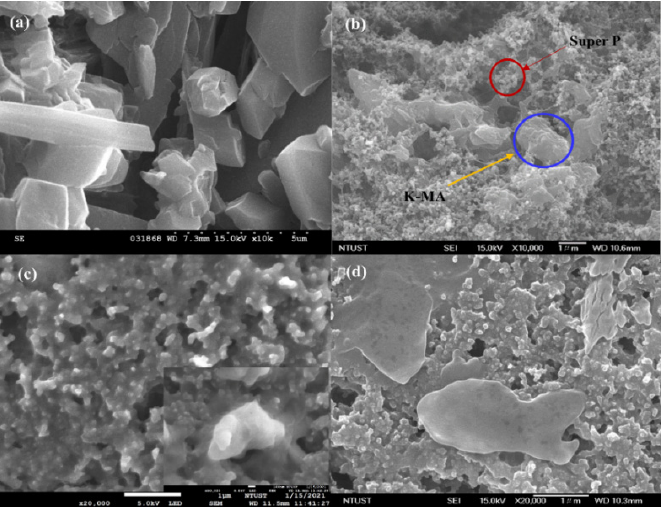
Figure 6. SEM images of ( a ) pure K − MA, ( b ) pristine K − MA, ( c ) K-MA_LiFSI and ( d ) K − MA_KFSI after completing 200 cycles.